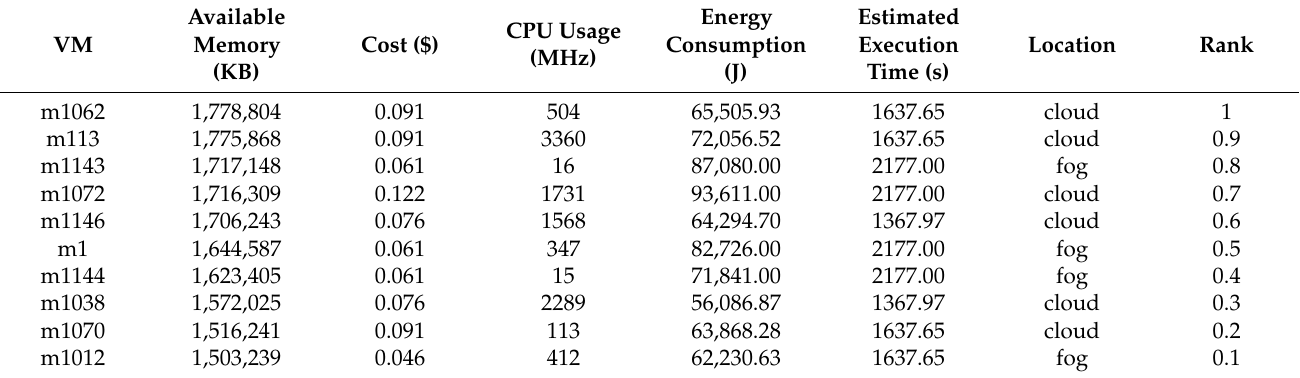
Table 11. Optimization results Task 224334 for a memory-driven use case with weights: w − MA =